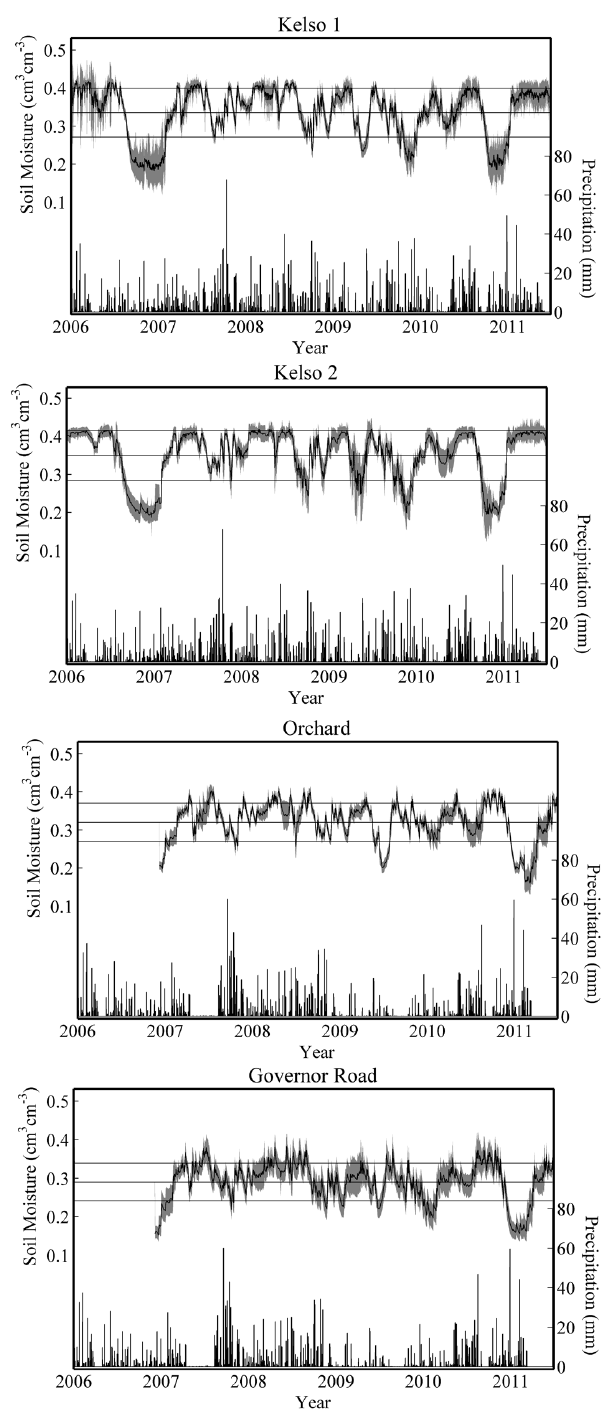
Fig. 6. Daily time series of mean soil moisture in the top 50cm (black line) and precipitation (bars) for the McMaster Mesonet. The middle horizontal lines represent the mean of all observations at each site and one standard deviation, whereas the grey shaded area represents the spatial standard deviation for each sampling